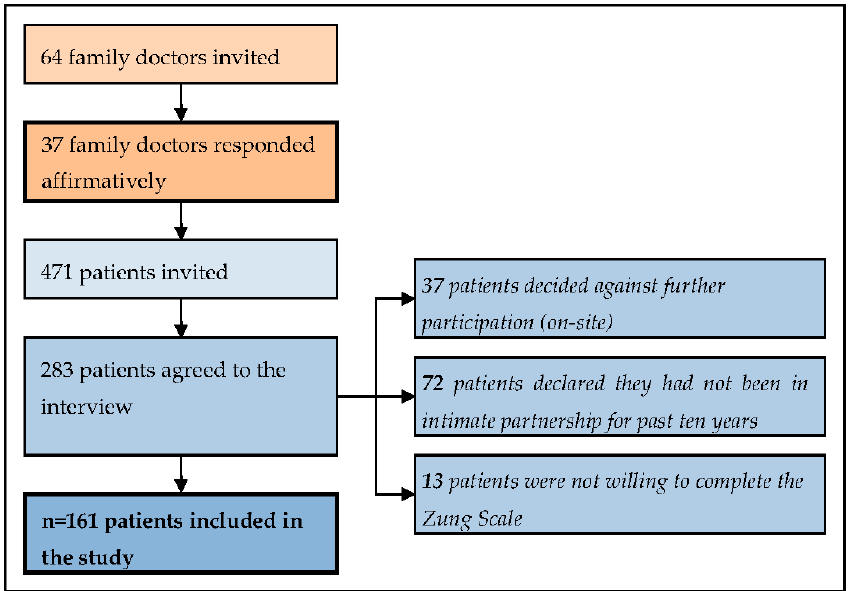
Figure 1. The drop ‐ out data. Figure 1. The drop-out